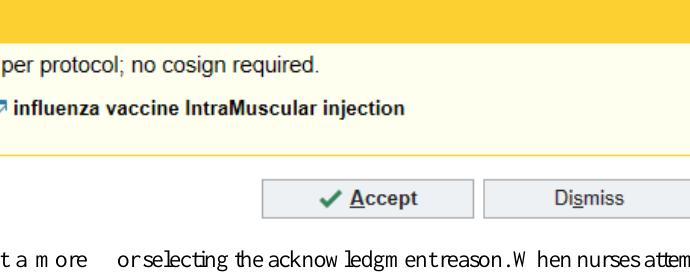
Figure 3. New version of the flu alert tested in the randomized controlled trial (RCT), with a simpler header and more directed verbiage that states “RN to order. Per Protocol; no cosign required”. Copyright 2020, Epic Systems Corporation.